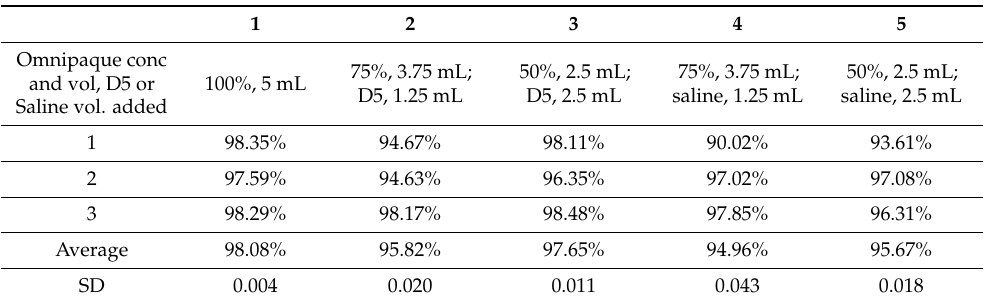
Table 2. The radiochemical purity as a percentage (%RCP) at various concentrations of omnipaque and D5 or saline solution ratio in five different samples ( 1 – 5